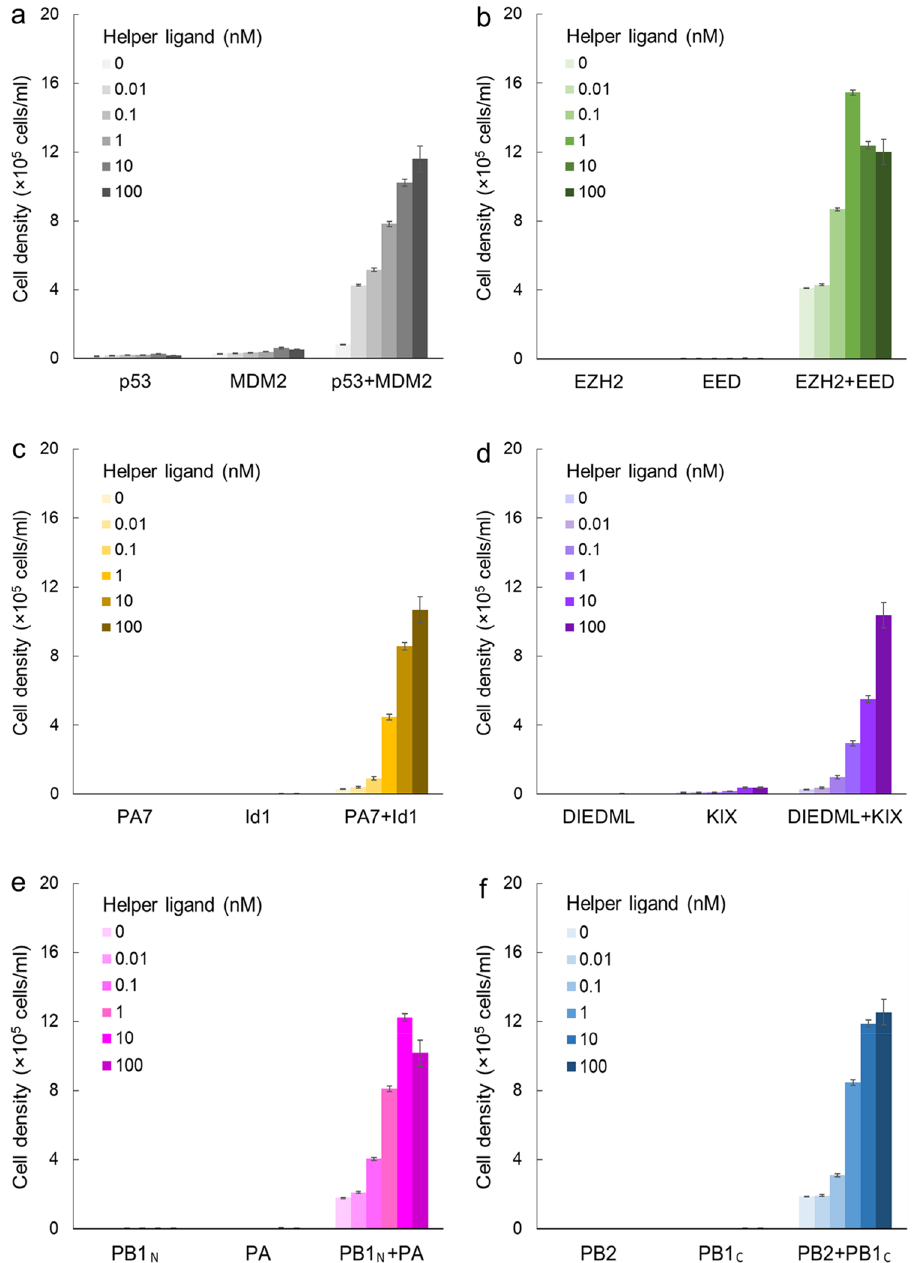
Figure 3. Detection of the endogenous/synthetic/viral peptide aptamer–polypeptide interactions based on cell proliferation. The chimeras expressed in the Ba/F3 transductants are shown as the abbreviated names. A cell proliferation assay was performed for detecting p53–MDM2 ( a ), EZH2–EED ( b ), PA7–Id1 ( c ), DIEDML–KIX ( d ), PB1 N –PA ( e ), and PB2–PB1 C ( f ) interactions with/without the serially diluted helper ligand (0.01, 0.1, 1, 10, 100 nM). The initial cell density was 1 × 10 5 cells/ml. The viable cell densities after 72 h are indicated as mean ± SD (n = 3, biological